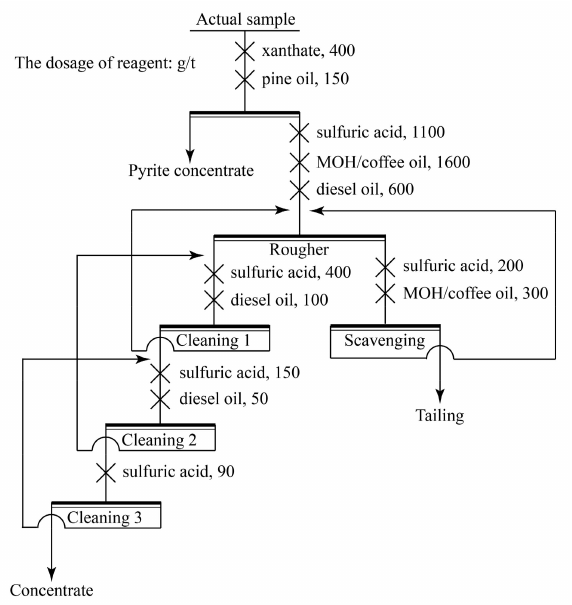
Figure 2. Experiment process of the closed-circuit test on ilmenite